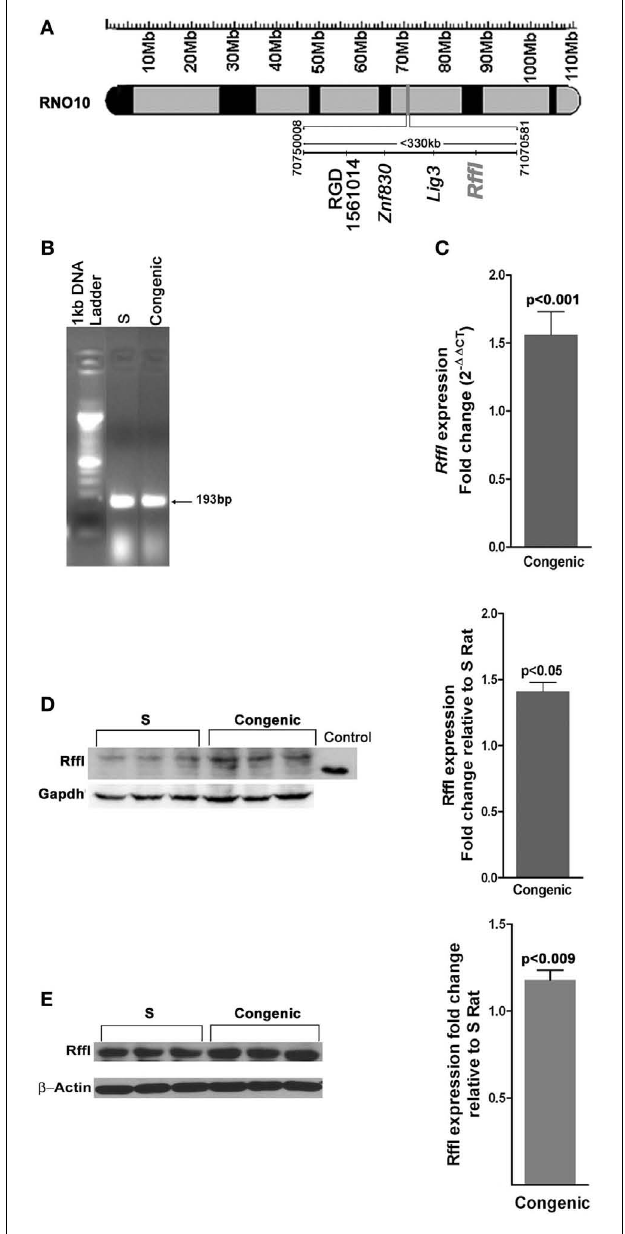
FIGURE 1 | (A) Schematic diagram of the congenic strain used in the study.The < 330kb region spanned by the congenic strain S.LEW (10) × 12 × 2 × 3 × 5 is shown alongside the physical map of rat chromosome 10.The basepairs delineating the ends of the congenic segment and the gene annotations were obtained from Ensembl.org. (RGSC 3.4) RNO10, Rat chromosome 10; Mb, Megabases. (B) Expression of Rffl transcript in the kidneys at 53days of age as detected by RT-PCR. (C) Quantification of Rffl transcripts relative to S rats by real-time PCR using whole kidney samples from 53-day-old rats ( n = 6 animals per group). Immunoblot of Rffl in (D) whole-cell lysates from S ( n = 3) and congenic ( n = 3) rat kidneys at 53days of age; (E) proximal tubules from S ( n = 3) and congenic ( n = 3). RFFL (NP_0010717368, 2aa-99aa, 36.41kDa) partial recombinant protein was used as positive control and Gapdh was the loading control. Quantification of Rffl protein ± SEM is shown